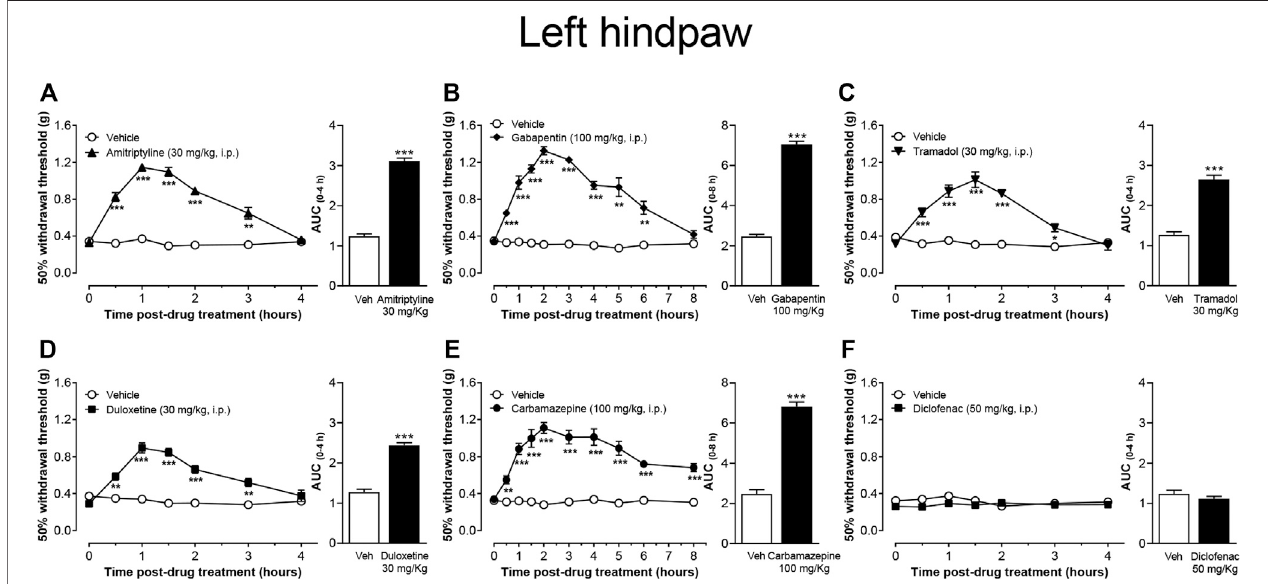
FIGURE4| Effect of the most common drugs used in the treatment of neuropathic pain, and diclofenac on mechanical skin hypersensitivity on the left hindpaw of CAF + STZ mice. Values are means ± SEM (n (cid:1) 8). ** p < 0.01, *** p < 0.001; signi fi cantly different from the vehicle group by Repeated Measures Two-Way ANOVA, followed by Bonferroni ’ s test. Attached the AUC of the effect is also shown, *** p < 0.001, t -student test.